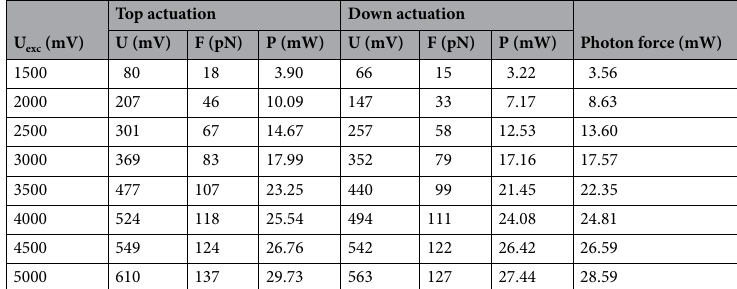
Table 1. Measured photon forces and actual differential signals present in the setup.